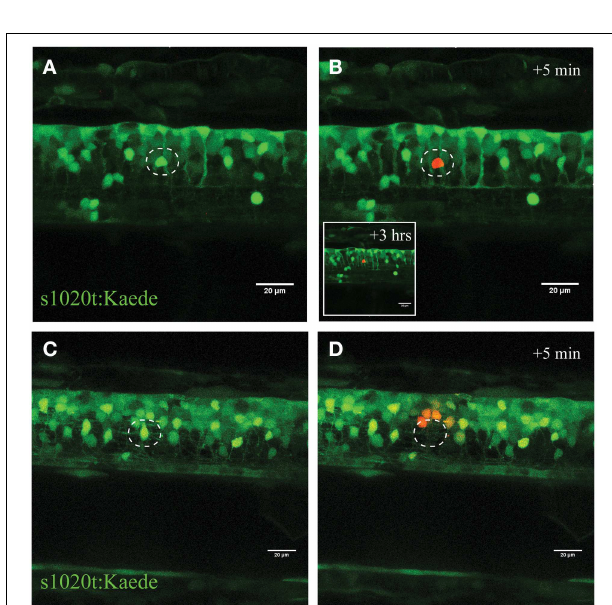
radiated anterogradely toward the distal end of the axon (C) , until finally the fluorescence in the soma disappears and the entire axon shows “blebbing” (D) . Scale bars = 20 µ m. Supplementary Video 1 shows the time-lapse video of this process.